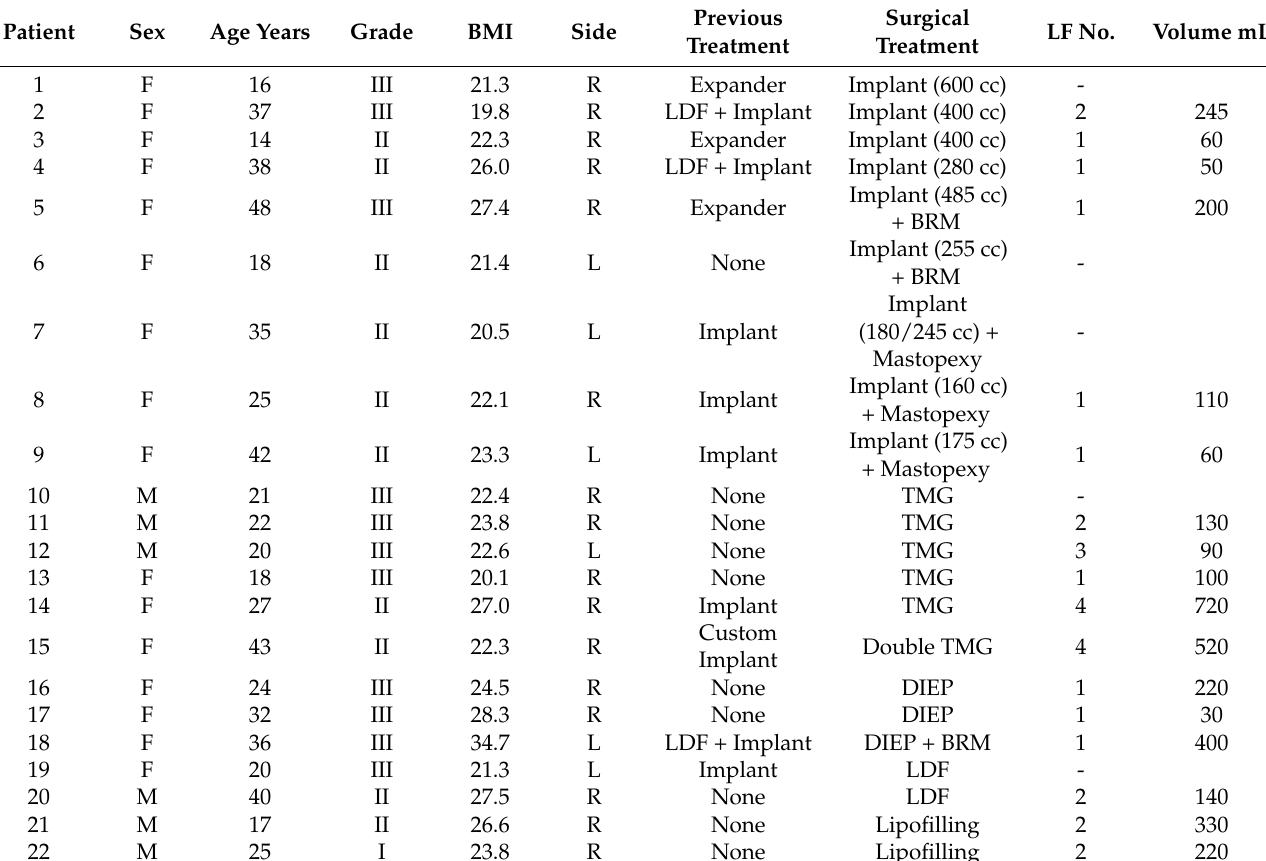
Table 3. Overview and clinical presentation of patients.